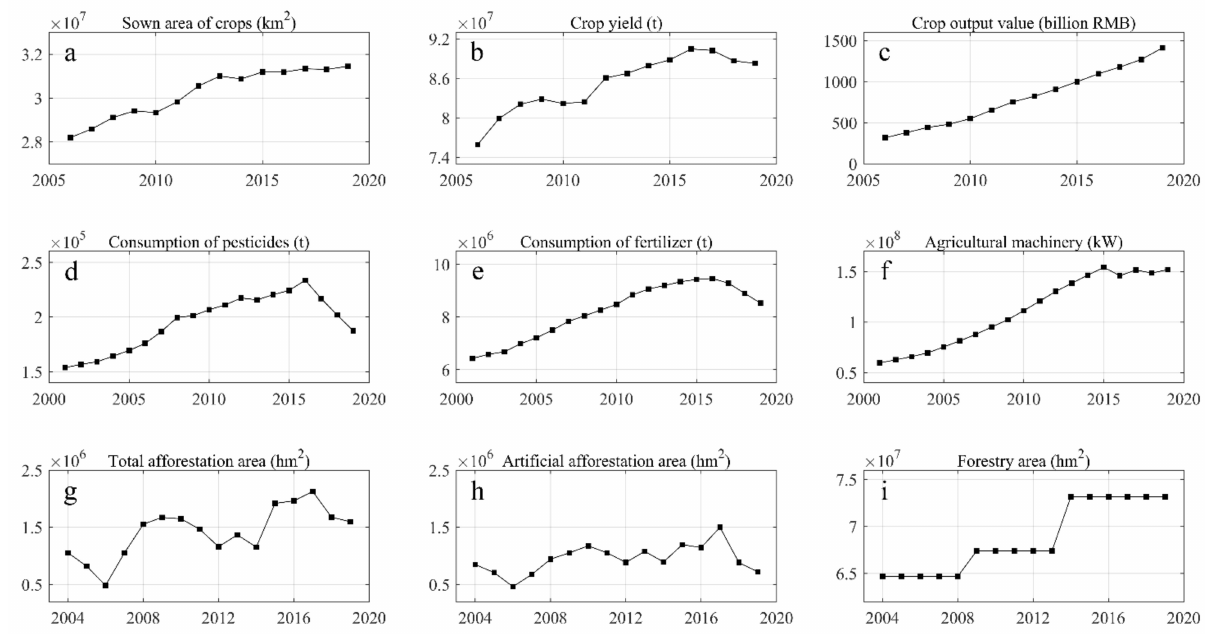
Figure 8. Agricultural and forestry changes in SWC. ( a – f ) are agricultural changes, which are crop sown area, crop yield, crop output value, pesticide use, fertilizer use, total power of agricultural machinery, ( g – i ) are forestry changes, which are total afforestation area, artificial afforestation area, and forest area, respectively.